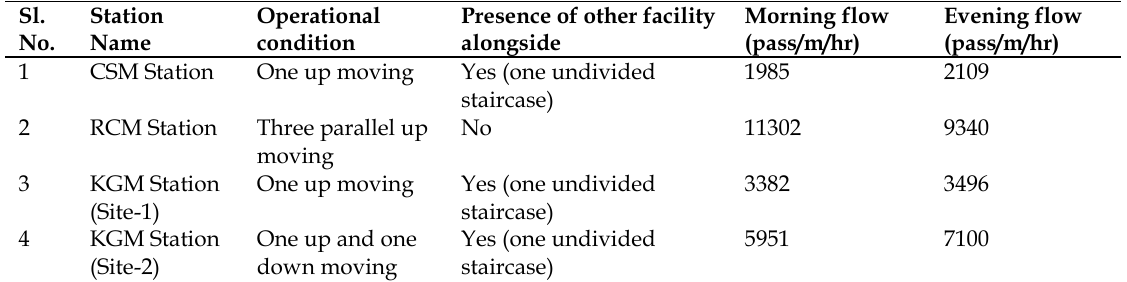
Table 3. Operational Characteristics of Selected Escalators